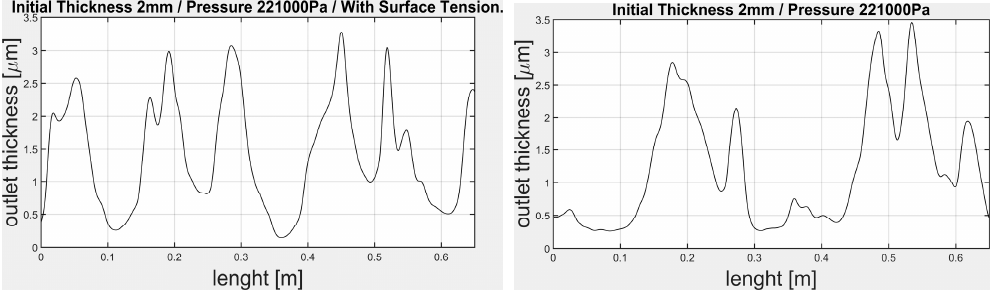
Figure 5. Thickness vs. distance (( Left ) with surface tension, ( Right ) without surface).